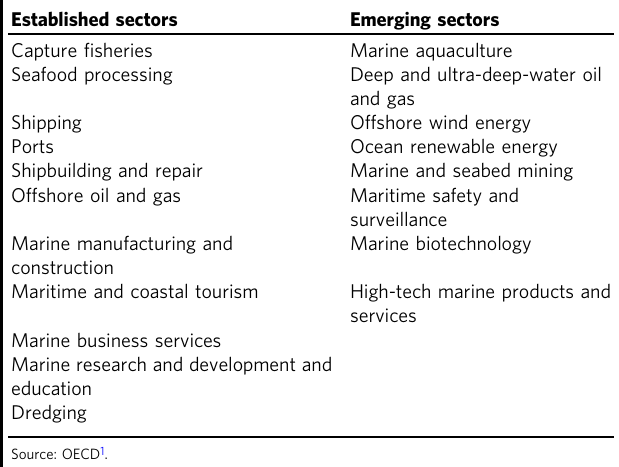
Table 2 Examples of established and emerging sectors in the ocean